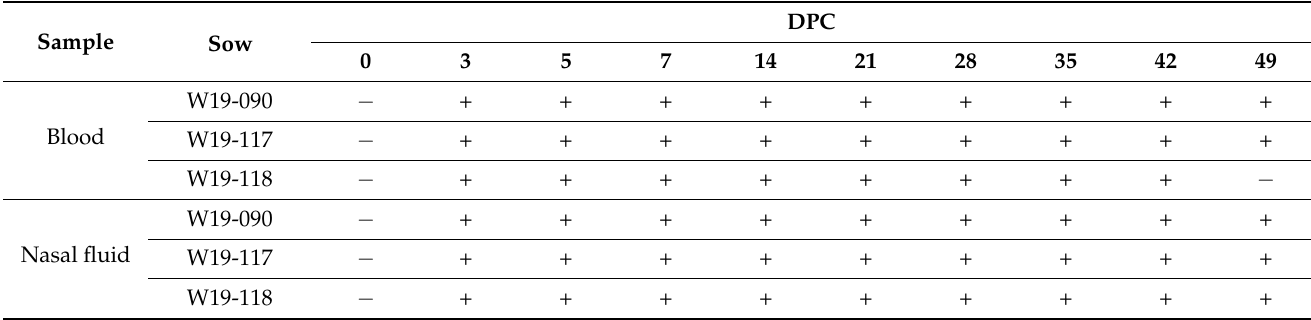
Table 1. PPV1 detection in the blood and nasal fluid samples from sows infected with the PPV1-190313 strain. Blood and nasal fluid samples were collected at the specified number of days postchallenge (DPC) and analyzed for PPV1 presence by conventional PCRs; +, PPV1 -positive; − , PPV1 -negative.